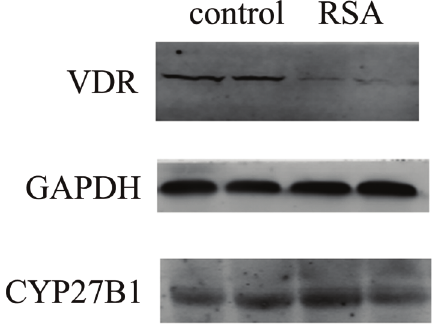
Figure 3. Vitamin D receptor (VDR) and 1- a -hydroxylase (CYP27B1) protein expressions in decidual tissues determined by western blotting. Expression levels were normalized with glyceraldehyde-3-phosphate dehydrogenase (GAPDH). VDR and CYP27B1 were expressed in both the recurrent spontaneous abortion (RSA) and the control groups. VDR was weakly expressed in the RSA group compared to the control group. There was no difference in CYP27B1 expression between the two